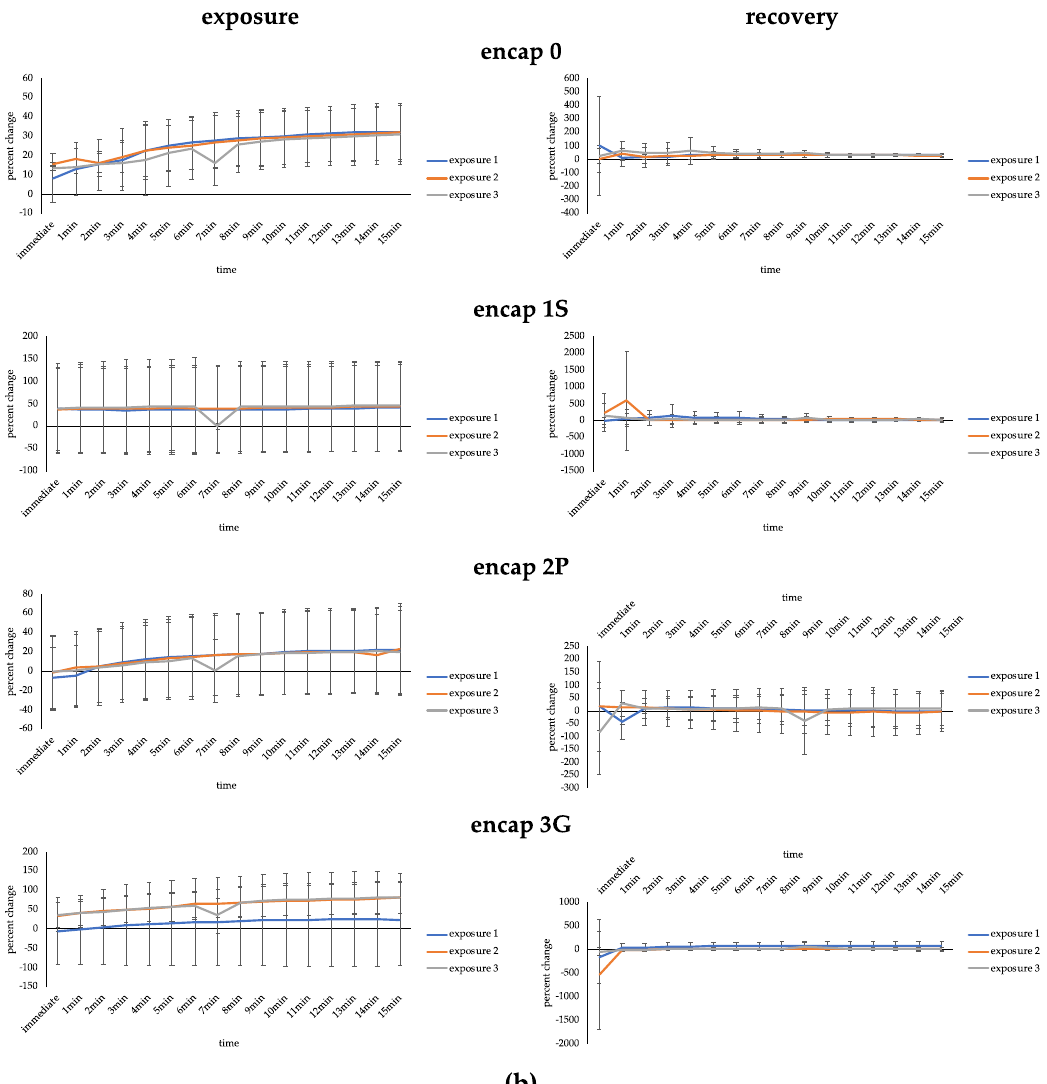
Figure 2. Effect of temperature and humidity on electrical conductivity. ( a ) Wool. ( b )